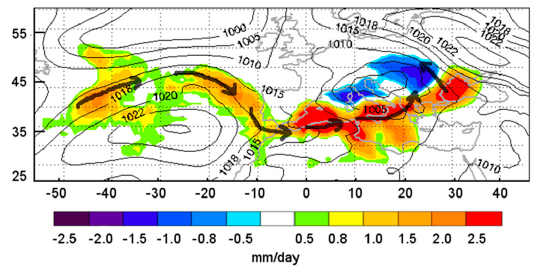
Figure 8. Anomalies of moisture sources (E − P > 0) obtained from the backward analysis during 10 days for the 23 September 1996 wet spell. SLP in black contours for 23 September 1996. Grey arrows indicate schematically the flow of the moisture from the Northern Atlantic Ocean to the DRB crossing the Mediterranean basin.